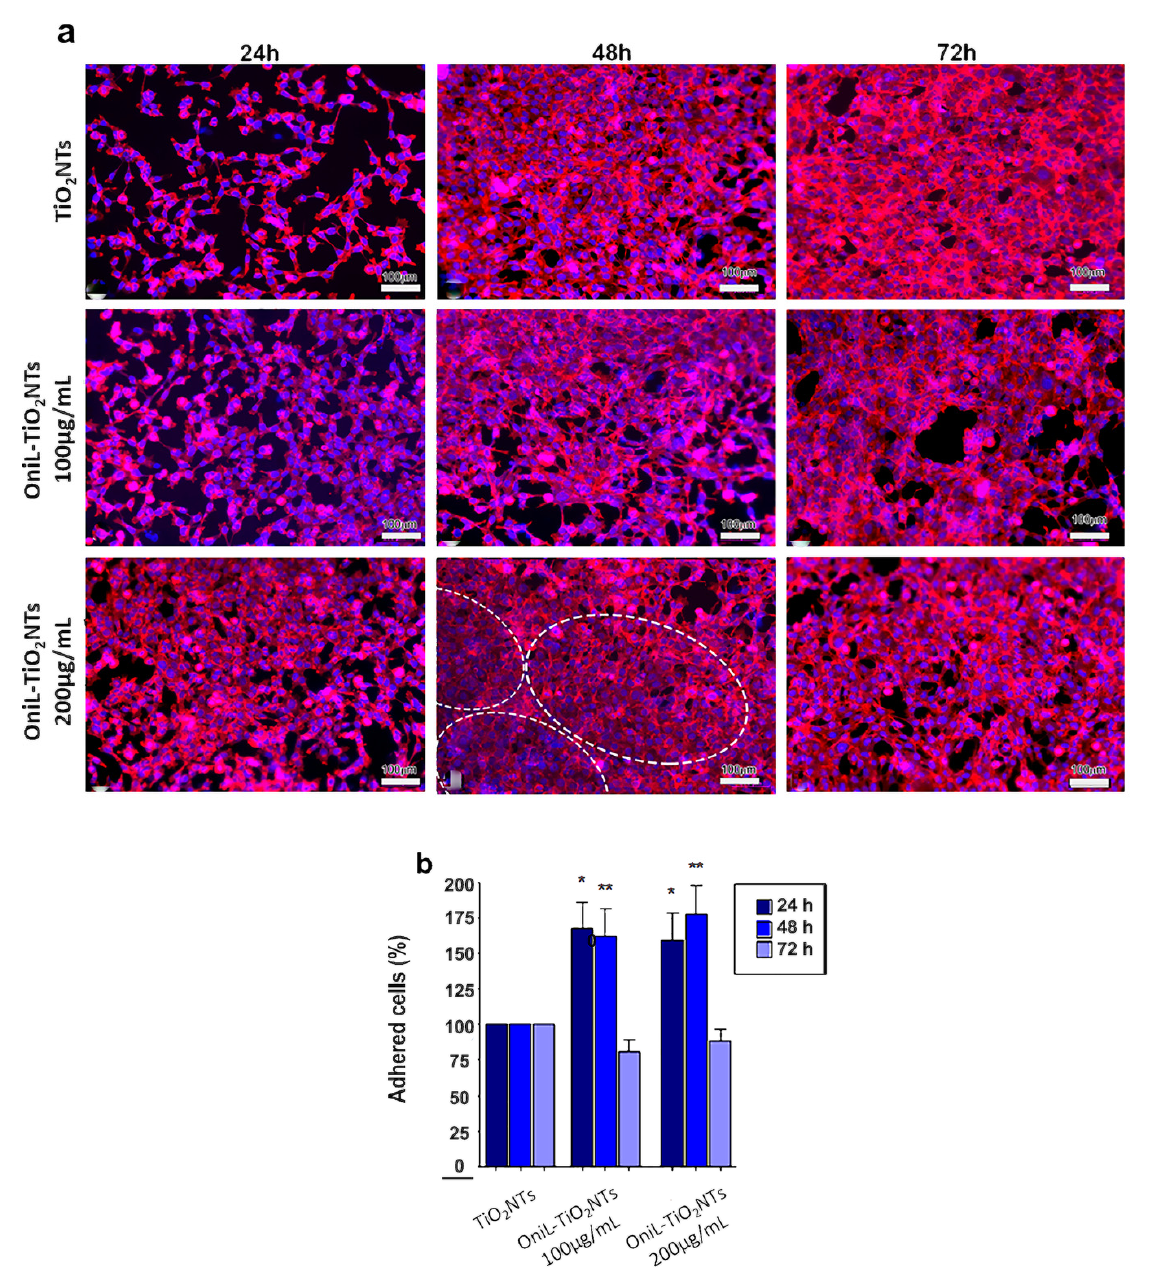
Figure 4. Biocompatibility analysis of OniL-TiO 2 NTs. ( a ) Representative fluorescence images of osteosarcoma cells adhered on the surface of TiO 2 NT after 24, 48, and 72 h of cultivation. The actin filaments and nuclei were showed in the red and blue channel, respectively. Note the concentric orientation of cells in the OniL-decorated nanotubes samples (dashed circle). ( b ) The quantification of cell nuclei in the DAPI-stained osteosarcoma cells. Significant differences compared to TiO 2 NTs for (*) 24 h and (**) 48 h of incubation, p < 0.05. The data were obtained from two independent experiments in